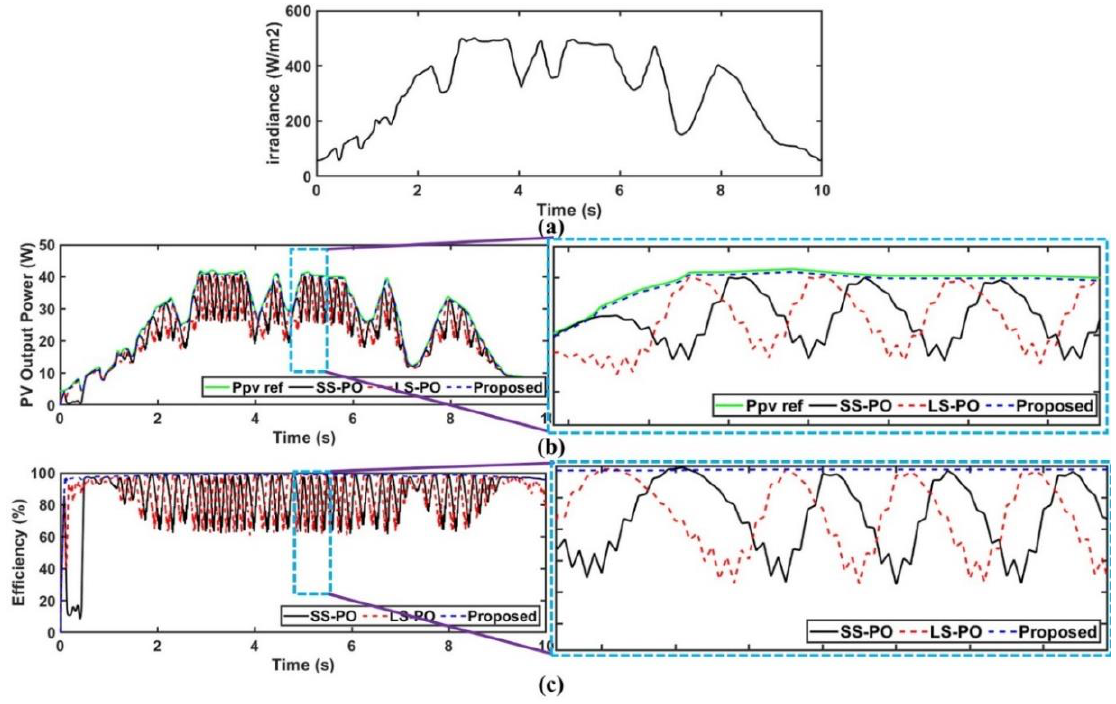
Figure 13. PV results: ( a ) One-day irradiance profile, ( b ) PV output power and ( c ) system-tracking efficiency.